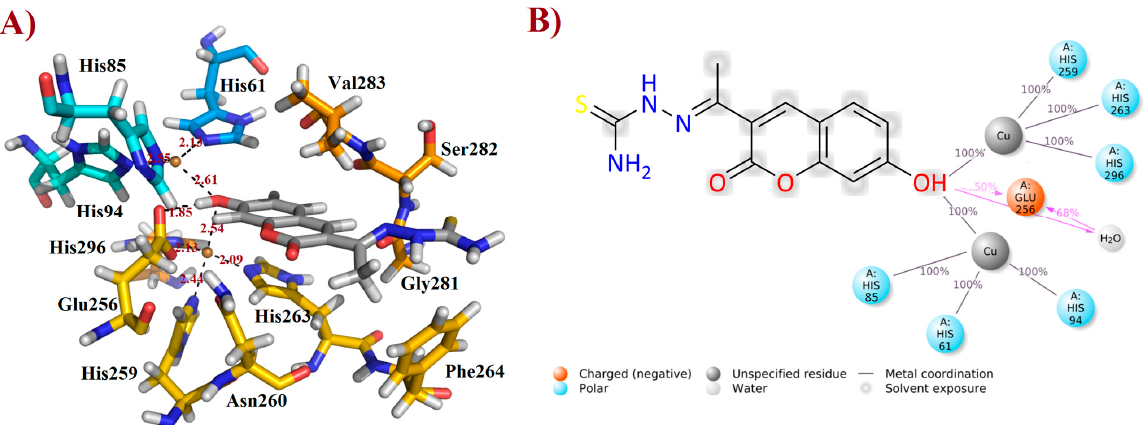
Figure 5. Interactions of FN ‐ 19 at the binding site of mushroom tyrosinase enzyme. In ( A ), black dashed lines mean metal coordination and hydrogen bonding interactions, and distance is measured in Ångström. Water molecules were removed from the ligand ‐ target complex for clarification. The illustration was elaborated using PyMOL ® v. 0.99. In ( B ), the illustration was created using Maestro ® v. 2022.1.